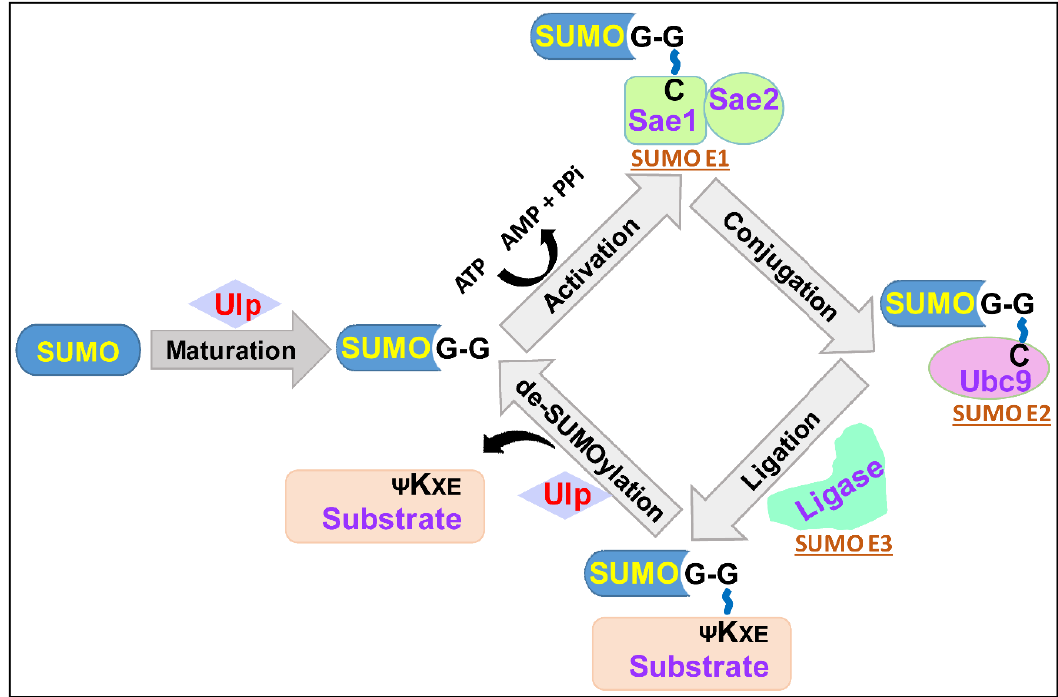
Figure 1. Schematic illustration of the steps involved in SUMO-conjugation and de-conjugation processes. SUMOylation starts with the action of SUMO-specific proteases (Ulp/SENP family) on newly synthesized SUMO, which leads to the generation of mature SUMO with exposed carboxyl-terminal GG motif. The second step involves SUMO-activating enzyme (E1)-mediated activation of the SUMO protein in an ATP-dependent fashion, by first inducing adenylation of the SUMO carboxyl-terminal, followed by the energy-rich thioester bond formation between the thiol group of cysteine present in the catalytic site of the E1 enzyme and the C-terminal glycine residue of the SUMO protein. The activated SUMO is next transferred from the E1 enzyme to the cysteine residue present in the catalytic site of the SUMO-conjugating enzyme (E2), through the thioester linkage. With the help of the SUMO ligase (E3), SUMO is further transferred from the E2 enzyme to the target protein via isopeptide bond formation between the C-terminal carboxyl group of SUMO and the ε-amino group of the lysine residue in the target protein. SUMO-specific proteases also cleave an isopeptide bond between SUMO and the target protein, resulting in the generation of an unSUMOylated target protein and free SUMO.